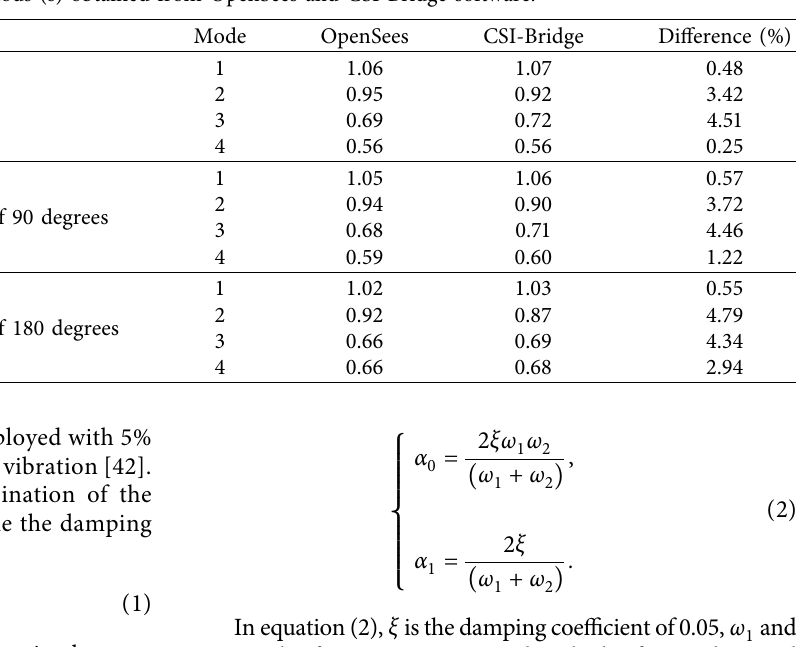
Figure 3: Stress-strain curves of (a) steel and (b) concrete materials. Table 5: Modal periods (s) obtained from OpenSees and CSI-Bridge